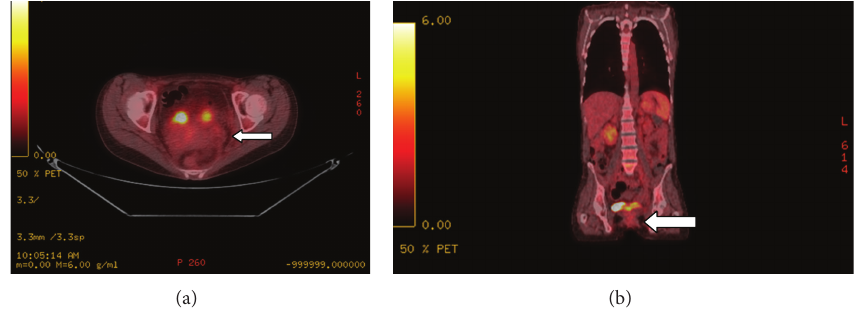
Figure 6: Axial (a) and coronal (b) PET-CT fusion images of the pelvis obtained a few months later after radiation demonstrate significant reduction in the lymphomatous mass (arrow), with no measurable